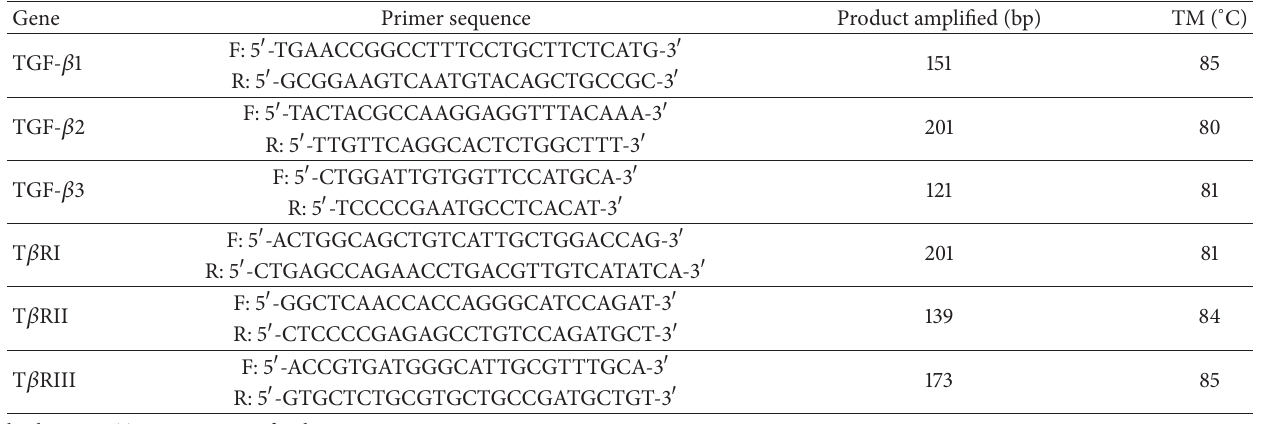
Table 1: Characteristics of primers used in experiment.